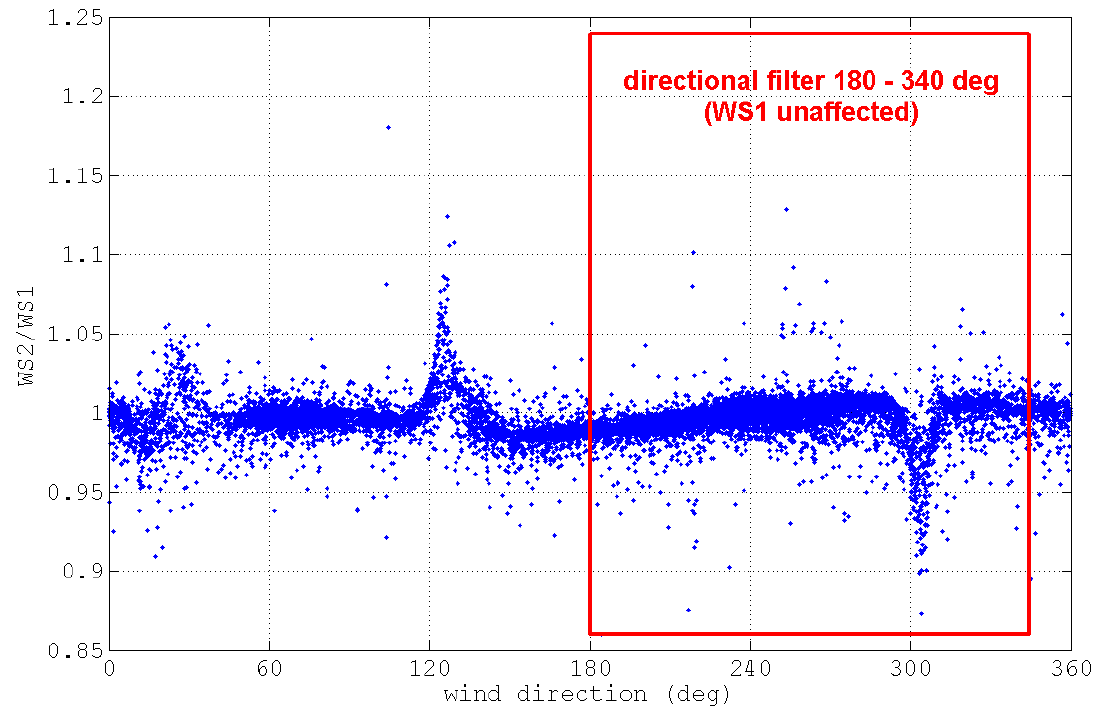
Figure 4. Directional variation in ratio of 80 m top-mounted anemometer wind speeds. (February–May; 10 min